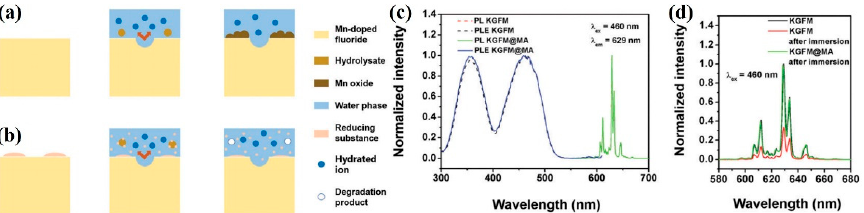
Figure 12. ( a ) Schematic diagram of water corrosion of K 2 GeF 6 : Mn 4+ and ( b ) K 2 GeF 6 : Mn 4+ @MA; ( c ) normalized excitation emission spectra for K 2 GeF 6 : Mn 4+ and K 2 GeF 6 : Mn 4+ @MA; ( d ) normalized emission spectra of K 2 GeF 6 : Mn 4+ and K 2 GeF 6 : Mn 4+ @MA before and after immersion in water for 168 h. (Reprinted from Ref [49]. Copyright from Royal Society of Chemistry, 2018).